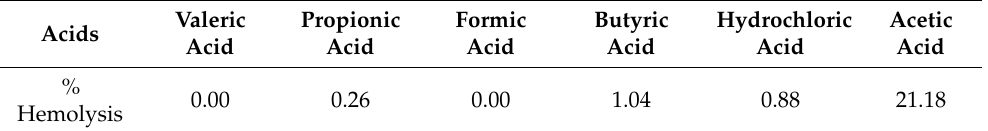
Table 8. Toxicity to human red blood cells measured as % of hemolysis in nonwovens modified by vapors of various acids (obtaining modified materials under gassing conditions).